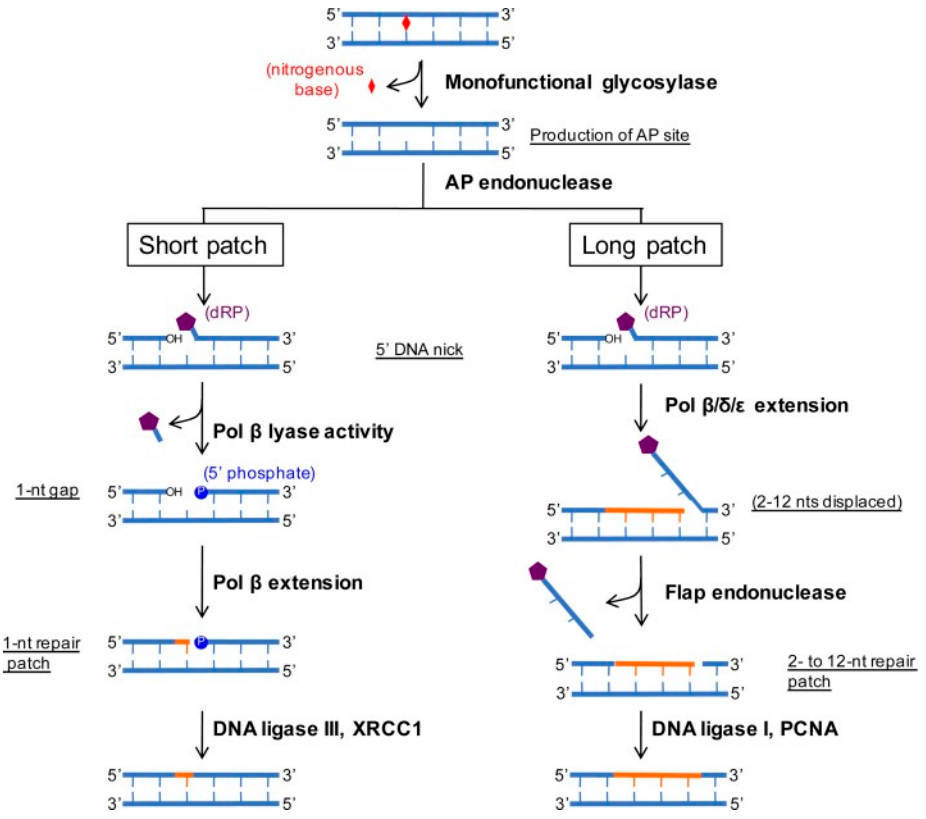
Figure 3. A schematic illustration of the short patch and long patch base excision repair (BER) pathways in eukaryotic cells. A non ‐ helix distorting lesion is recognized by a monofunctional glycosylase that cleaves at the N ‐ glucosidic bond, which releases the base. This creates an abasic site that is recognized by an AP endonuclease that creates a 5 ′ nick. This substrate is then processed by SP or LP repair. SP repair uses the lyase activity of pol β to remove the dRP moiety. Pol β extends 1 nt followed by DNA ligation by the DNA ligase III/XRCC1 complex. LP repair proceeds by pol β , δ , ε to extend ≥ 2 nts. The displaced DNA is cleaved by flap endonuclease followed by DNA ligation via the coordinated efforts of DNA ligase I and PCNA [64].